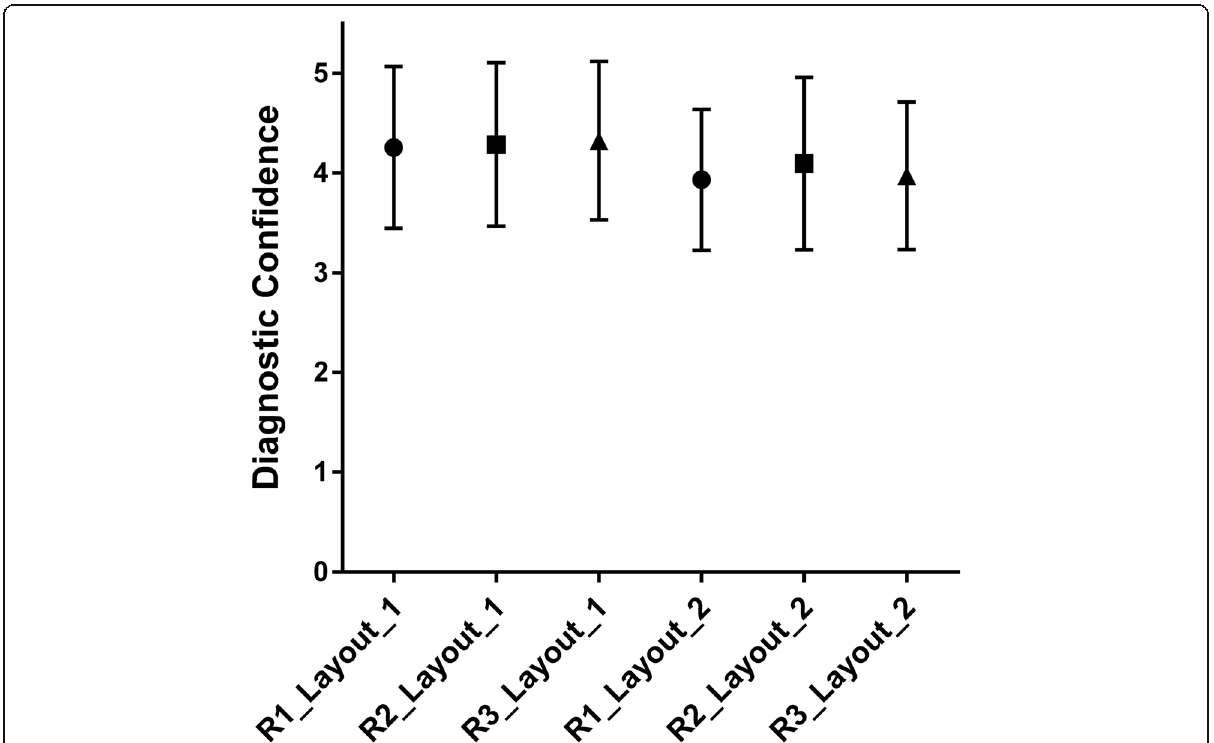
Fig. 6 Diagnostic confidence. This graph plots the mean scores ± standard deviation for the diagnostic confidence as assigned by the three readers (R1, R2, and R3) for the two image layouts: layout 1, fat-only images AND water-only images AND in-phase images as derived from the